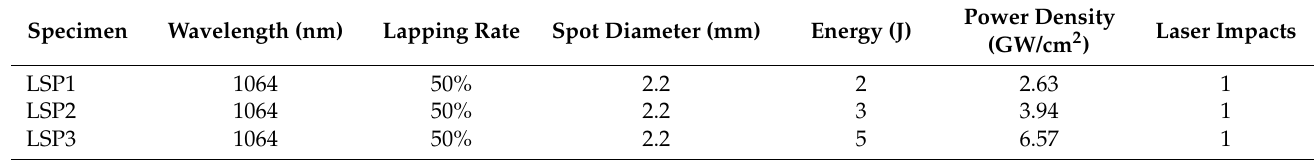
Table 3. Parameters of LSP